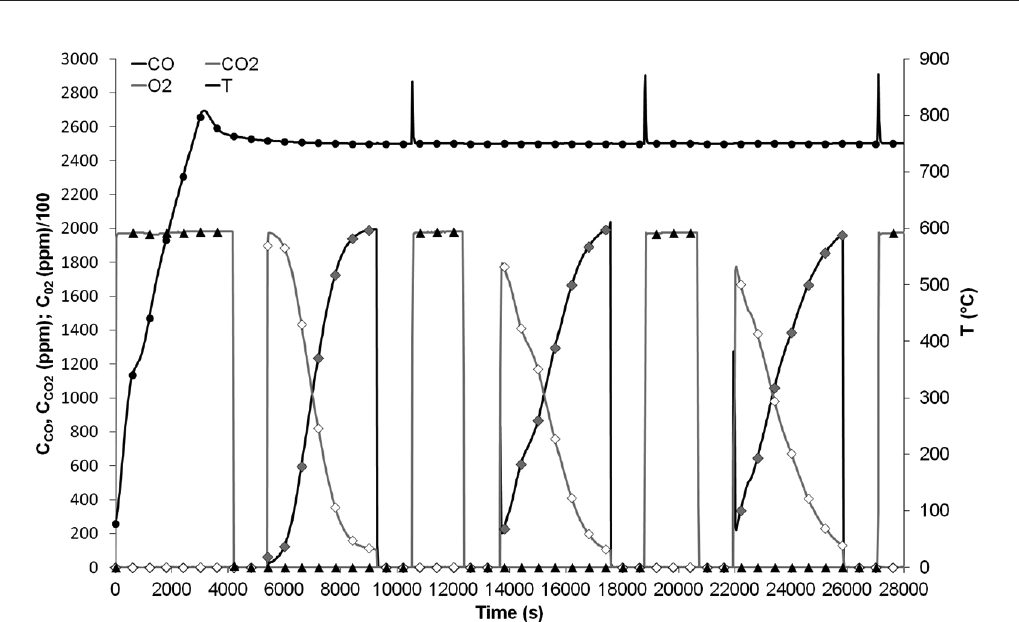
Figure 2. Oxidation-reduction cycles of 0.28 g of NiO/NiAl